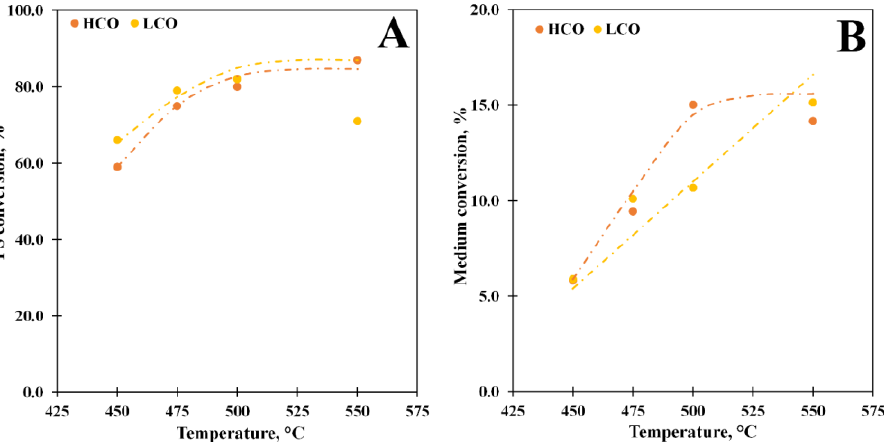
Figure 3. The conversion vs. temperature at WHSV 85 h − 1 for the PS solutions in LCO (15% PS) and HCO (10% PS) ( A ) and for pure LCO and HCO ( B